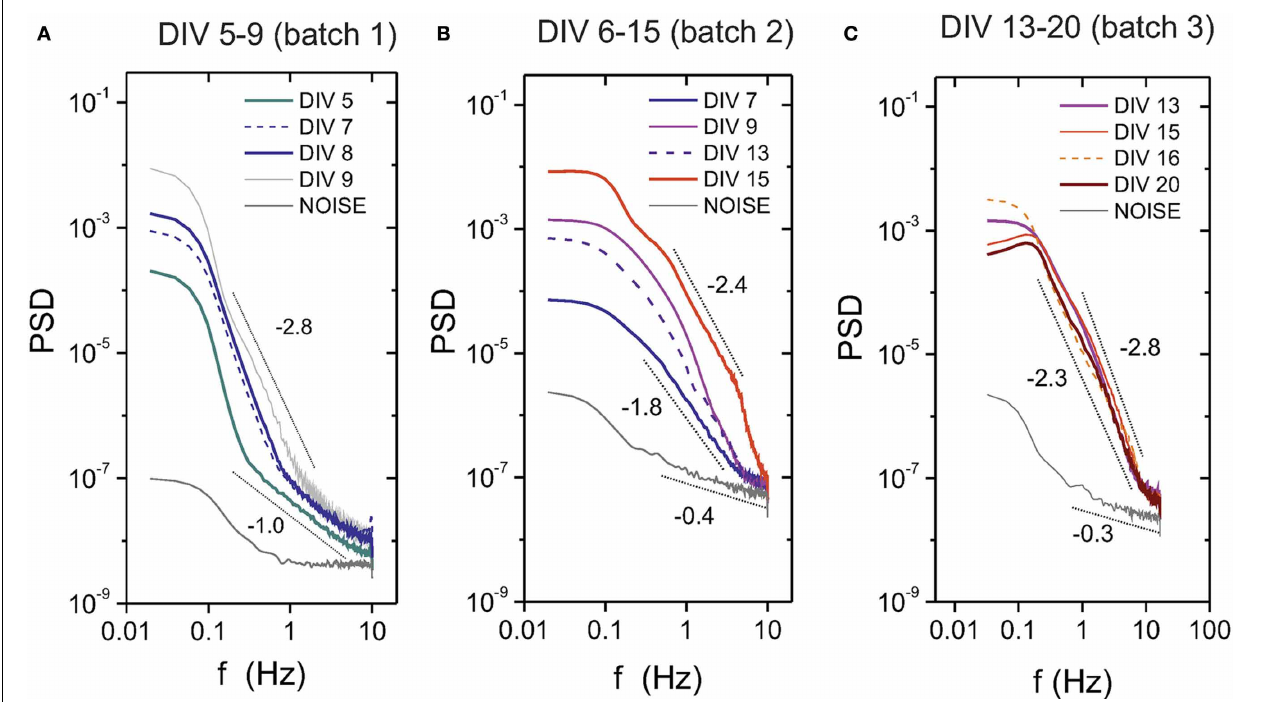
FIGURE 4 | Power spectrum density (PSD) during development for “E + I” networks. TheplotsshowthePSDevolutionforthreedifferentculturebatches (A–C) , covering in total about 3 weeks of development. The PSD gradually shifts upwards as the network matures, a feature that is accompanied by a